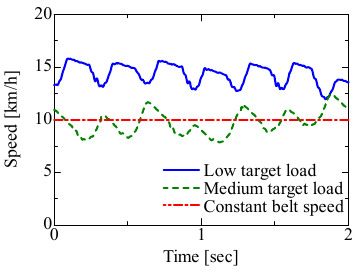
Figure 6. Results for speed in running conditions.